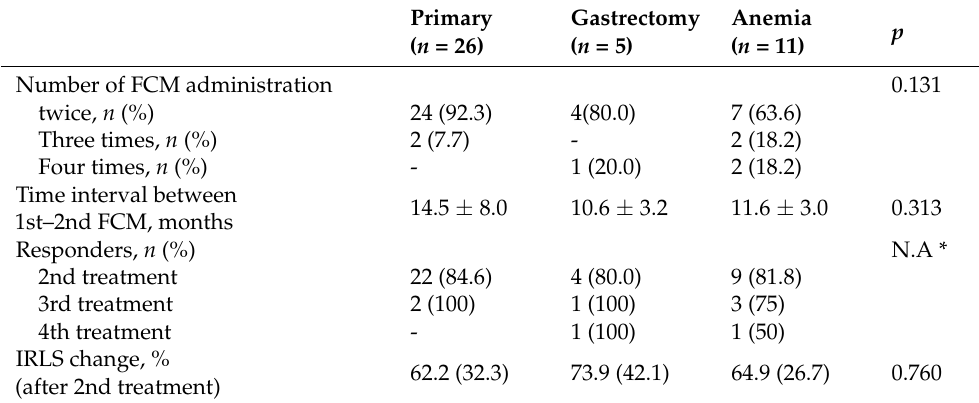
Table 2. The treatment response of repeated administration of FCM in primary and secondary RLS patients.